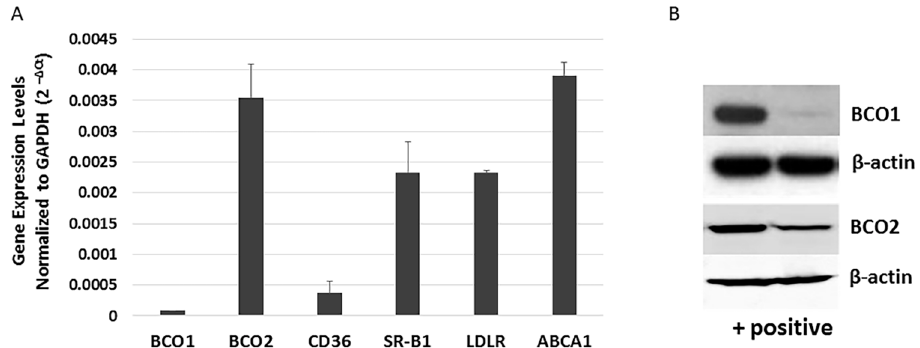
Figure 2. Expression of xanthophyll uptake-, metabolism- and transport-related genes in ARPE-19 cells. ( A ) mRNA levels of selected genes related to xanthophyll uptake (SR-BI, LDLR and CD36), metabolism (BCO1 and BCO2) and transport (ABCA1) in undifferentiated ARPE-19 cells were determined by qRT-PCR. ( B ) Western blot analysis verifying the difference in BCO1 and BCO2 expression. Left lane indicates (+) control cells (transfected HERK293); right lane shows ARPE-19 cells. 3.3. Effects of Selected Carotenoids on the Expression of BCO1, BCO2, and Scavenger Receptors in ARPE-19 Cells